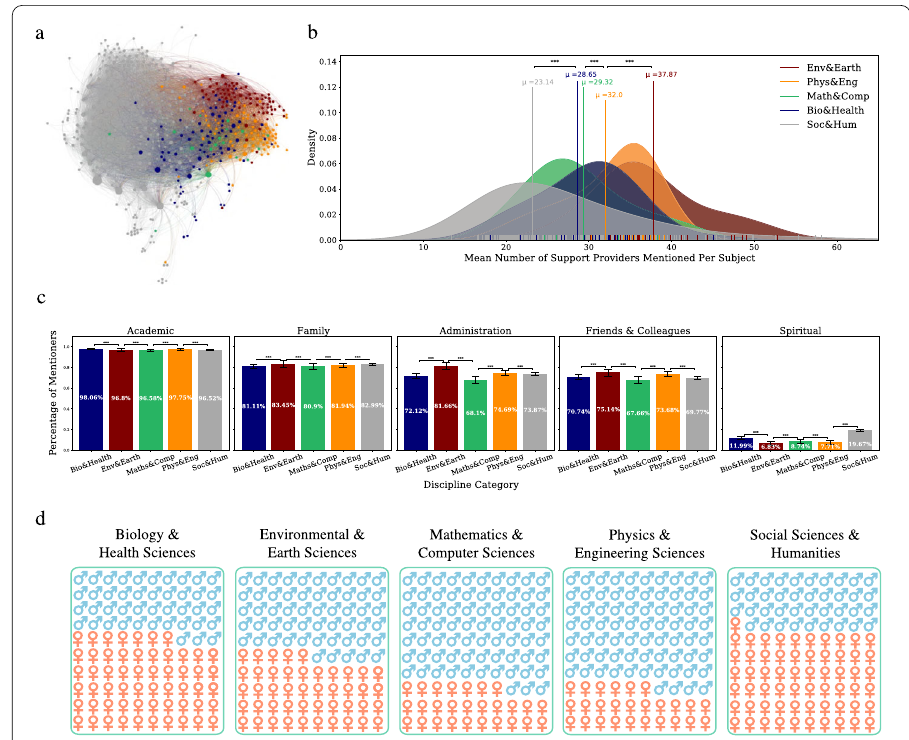
Figure 3 Disciplinary differences. Dissertation subjects are represented as nodes and the edges are formed by number of co-occurrences in the same document. This subject network reveals classification of field and the corresponding disciplines ( a ). Average number of support providers differ by disciplines ranging from individual to team sciences ( b ). Inclination to mention different support categories slightly diverge based on the discipline ( c ) and gender distributions observed to vary across disciplines ( d ). Individual groups were compared using the two-sided t-test. ***, p ≤ 0.001; **, p ≤ 0.01; *, p ≤